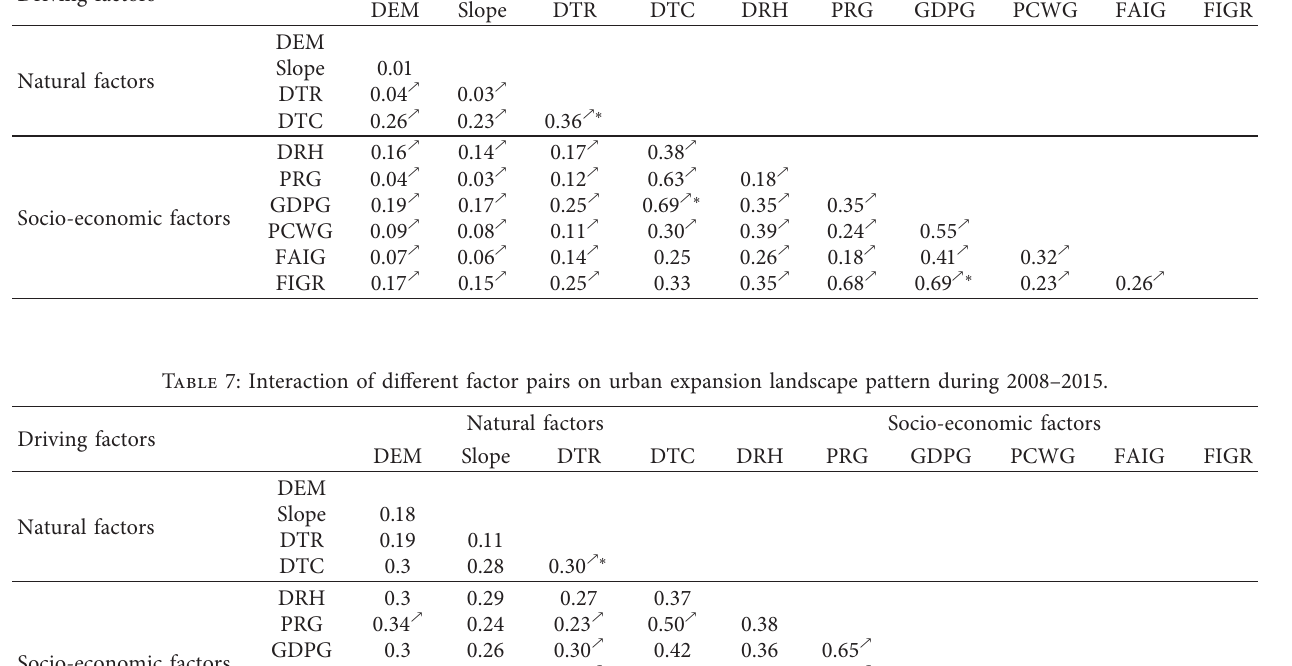
Table 6: Interaction of different factor pairs on urban expansion landscape pattern during 2000–2008. Driving factors Natural factors